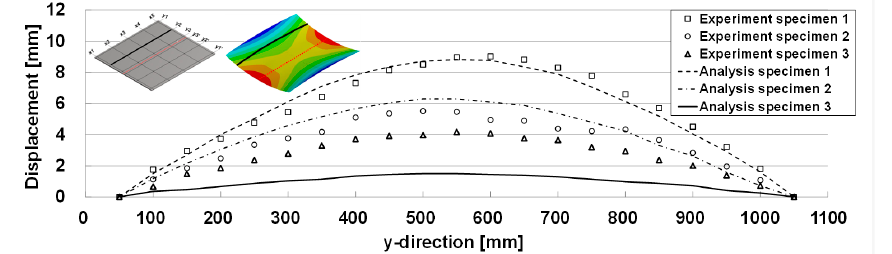
Figure 13. Butt welding analysis and experimental results (line x4).